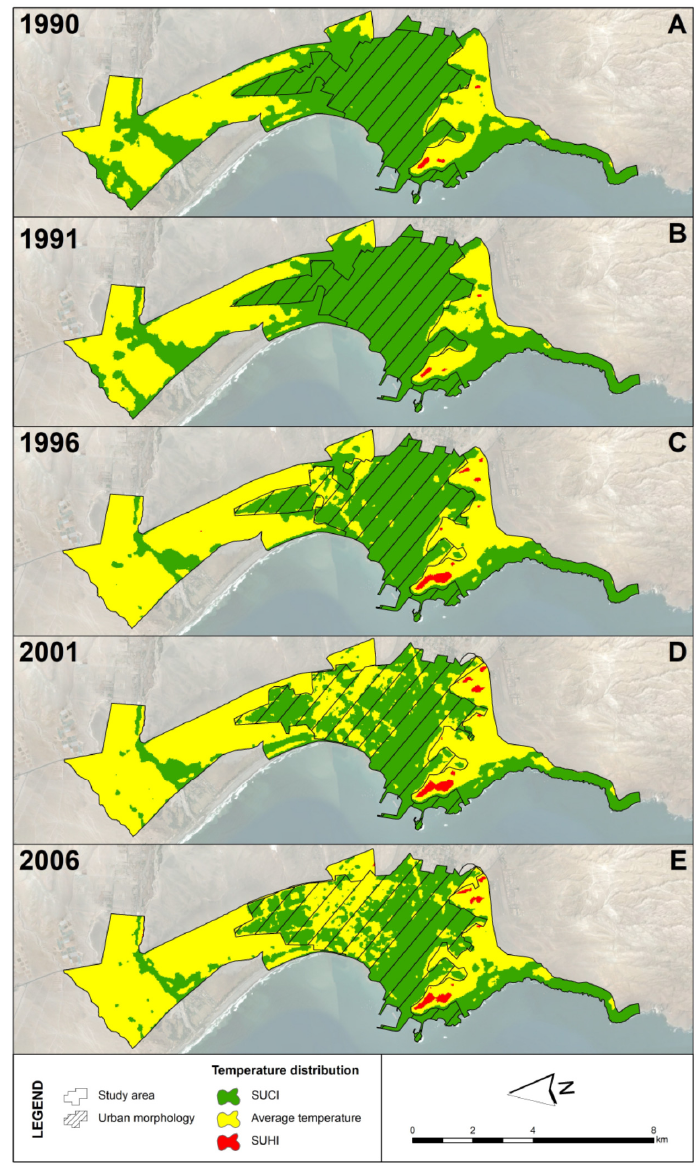
Figure 3. Locations of SUHI and SUCI and their spatial distribution in Arica during the colder years: ( A ) 1990, ( B ) 1991, ( C ) 1996, ( D ) 2001, and ( E ) 2006 As a result of the 1985–2019 period average, the SUHI extended over 3.4 km 2 , the UCI over 4.6 km 2 , and the average temperatures over 38.1 km 2 . Likewise, we recognised the